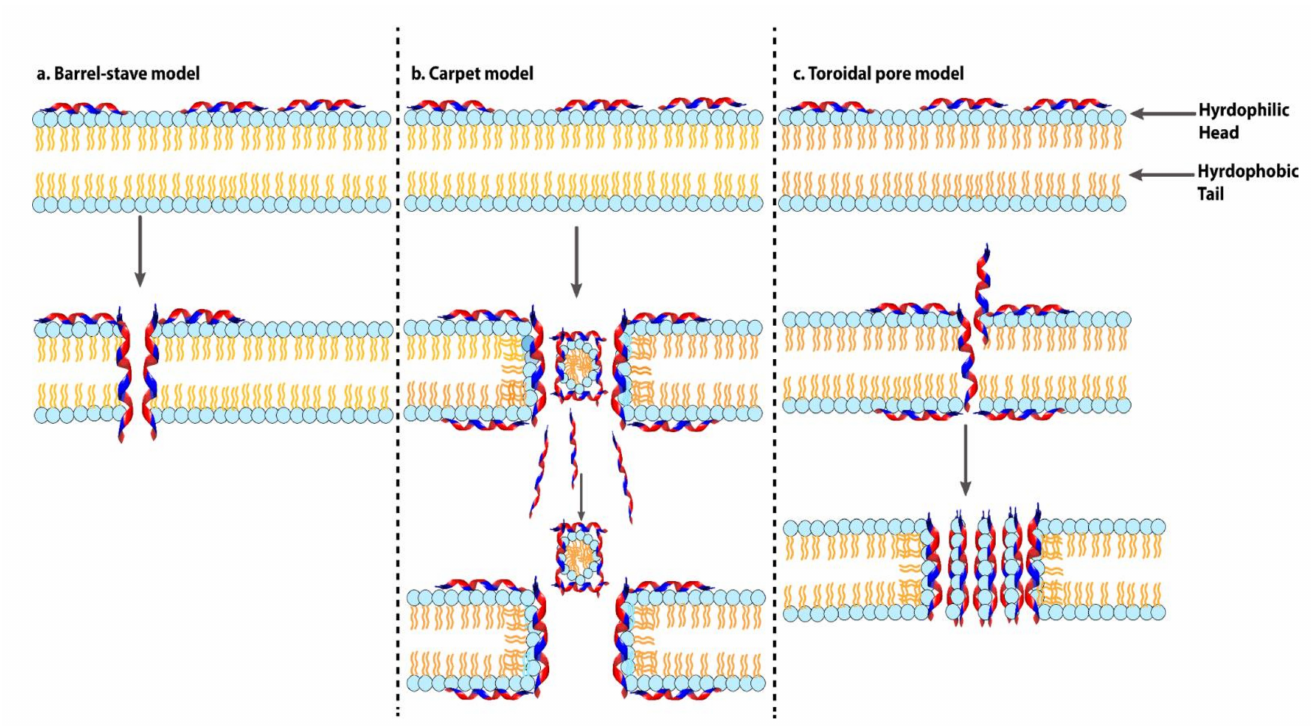
Figure 4. ( a ) Proposed barrel-stave model [443], ( b ) carpet model [444], and ( c ) toroidal pore model [445]. The hydrophilic and hydrophobic regions of the AMPs are represented in blue and red, respectively. The hydrophilic head and hydrophobic tail are represented in cyan and orange,